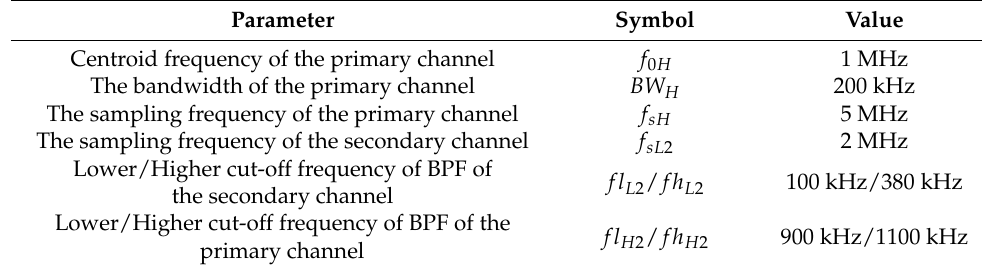
Table 1. The working parameters of PPPAAP19 for acquiring the